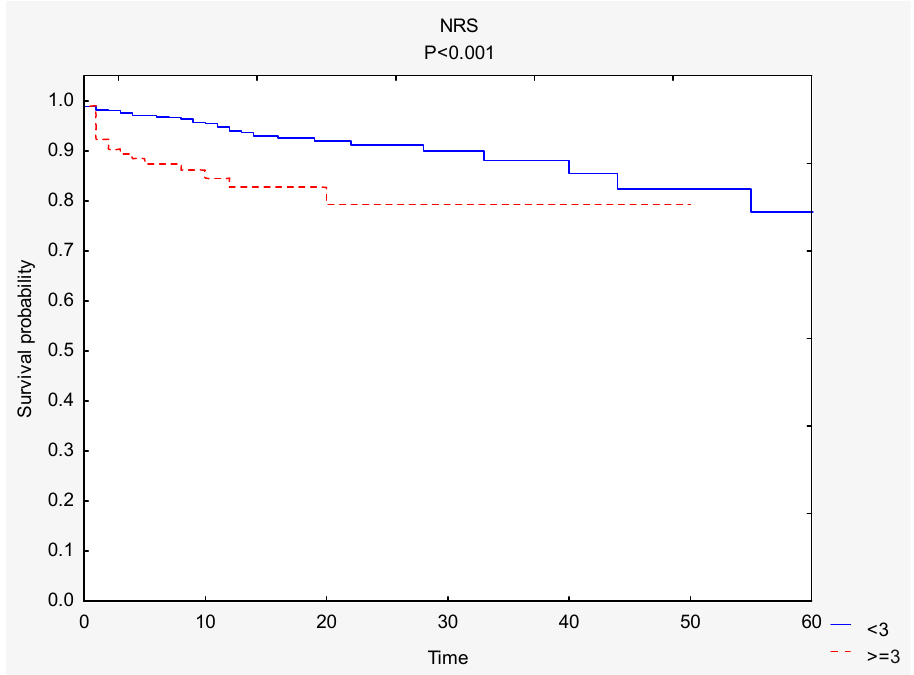
Figure 3. Comparison of survival curves depending on the NRS score. Abbreviations: NRS, nutritional risk screening.